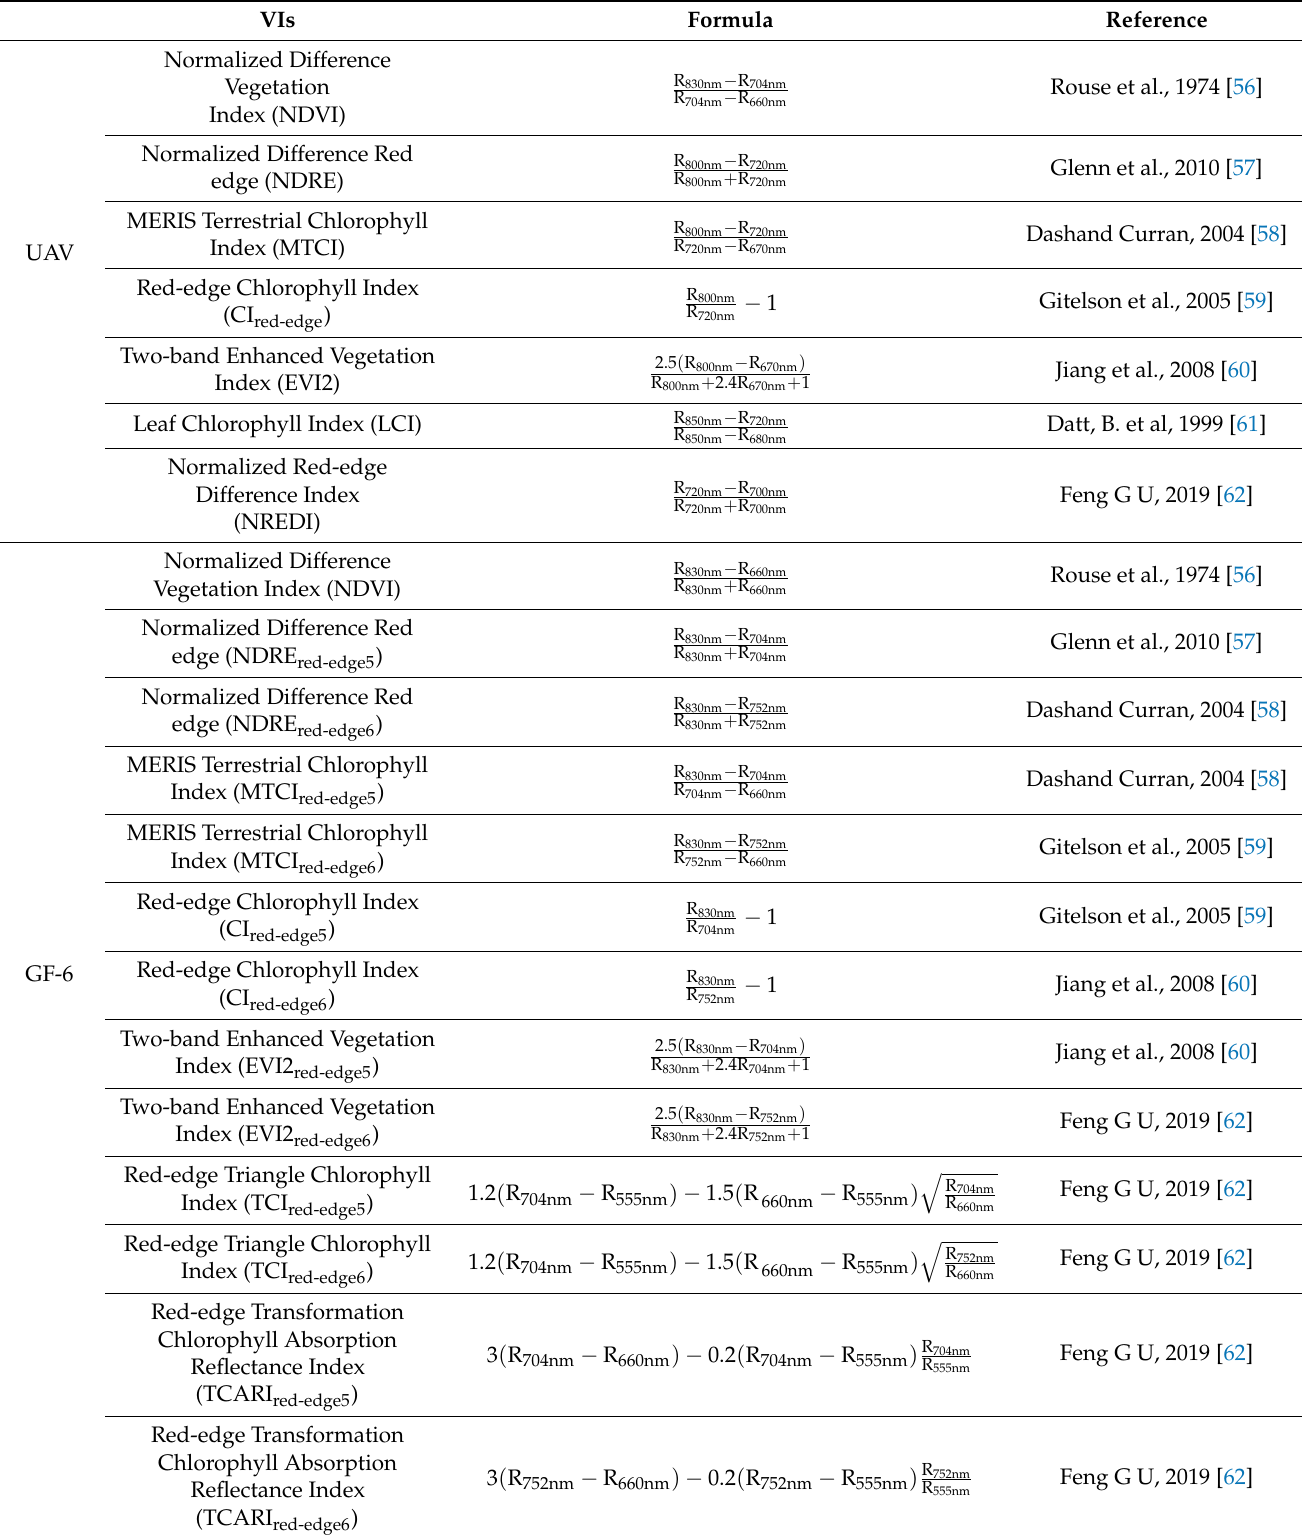
Table 2. The vegetation index for rice growth monitoring based on UAV and GF-6 images. Formula